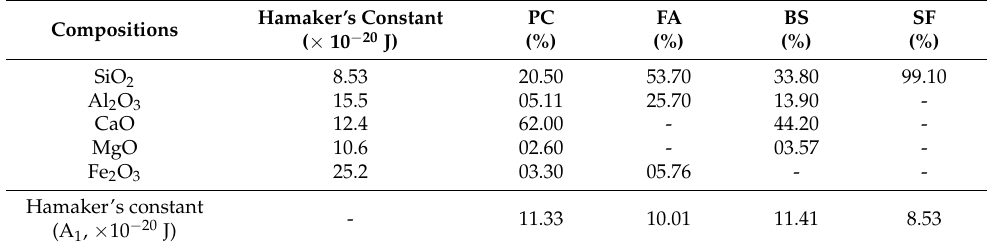
Table 5. Chemical compositions and their Hamaker’s constant of cementitious materials